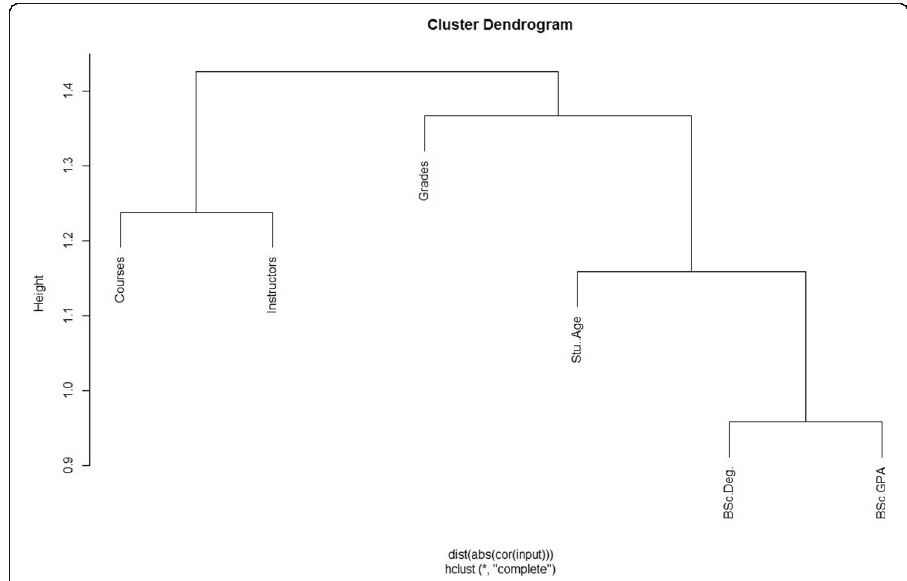
Fig. 6 Visualizing Dataset2 using Heat map